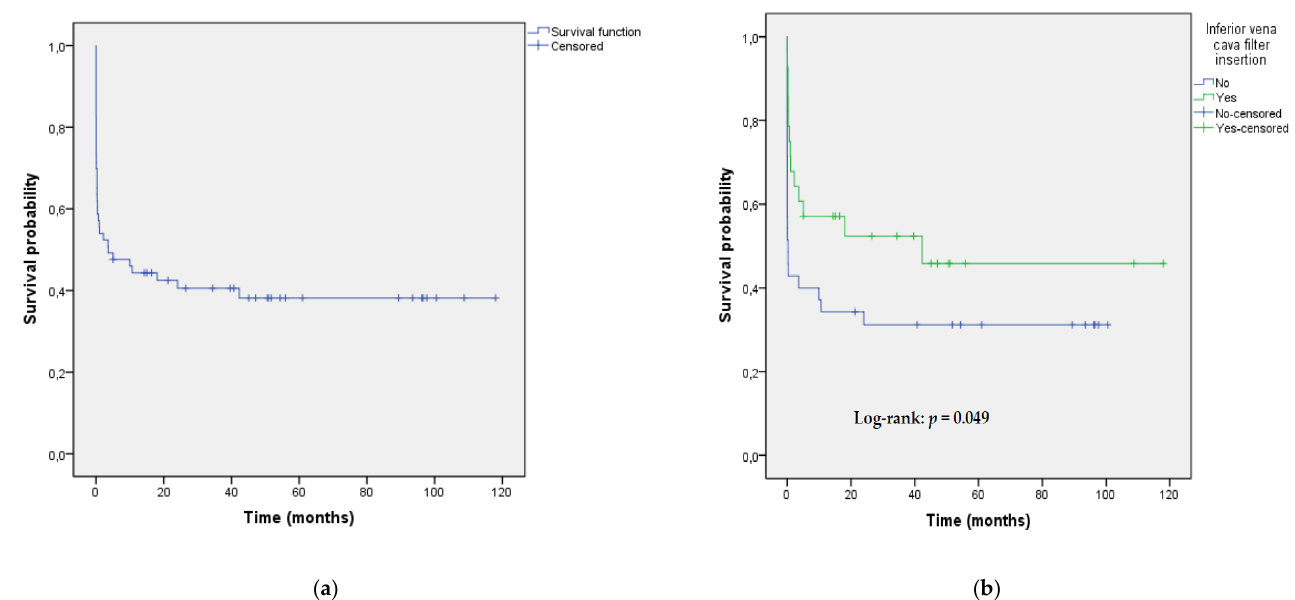
Figure 2. ( a ) Kaplan–Meier survival estimates from the time of endovascular reperfusion therapy for the whole group of 63 patients with pulmonary embolism (20-month, 40-month and 100-month survival estimates were 0.42, 0.40 and 0.38, respectively); ( b ) Kaplan–Meier survival estimates from the time of endovascular reperfusion therapy stratified by inferior vena cava filter insertion.